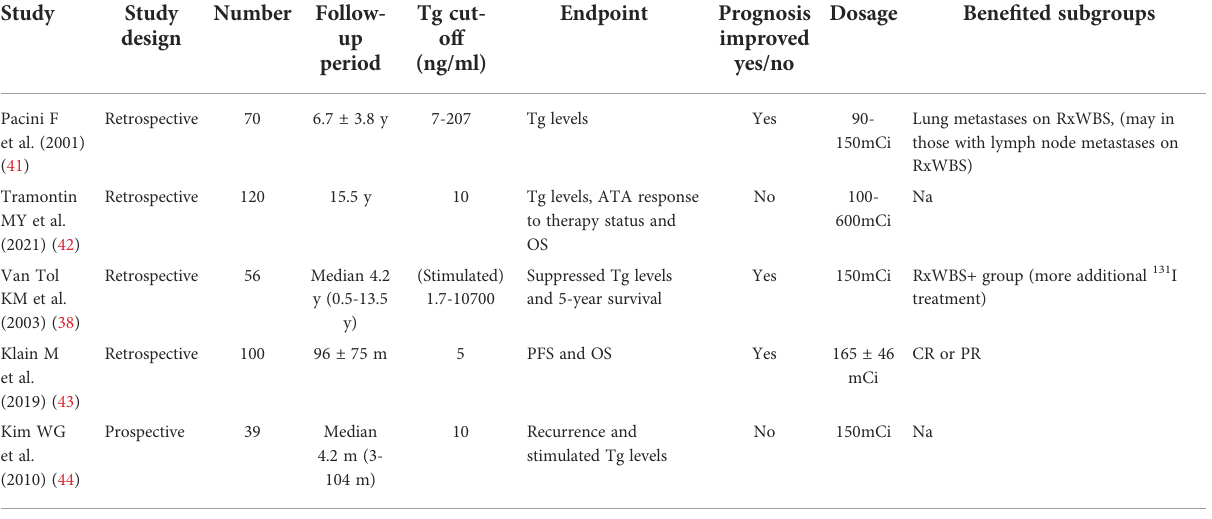
TABLE 5 Clinical outcomes of response to therapy evaluation guided